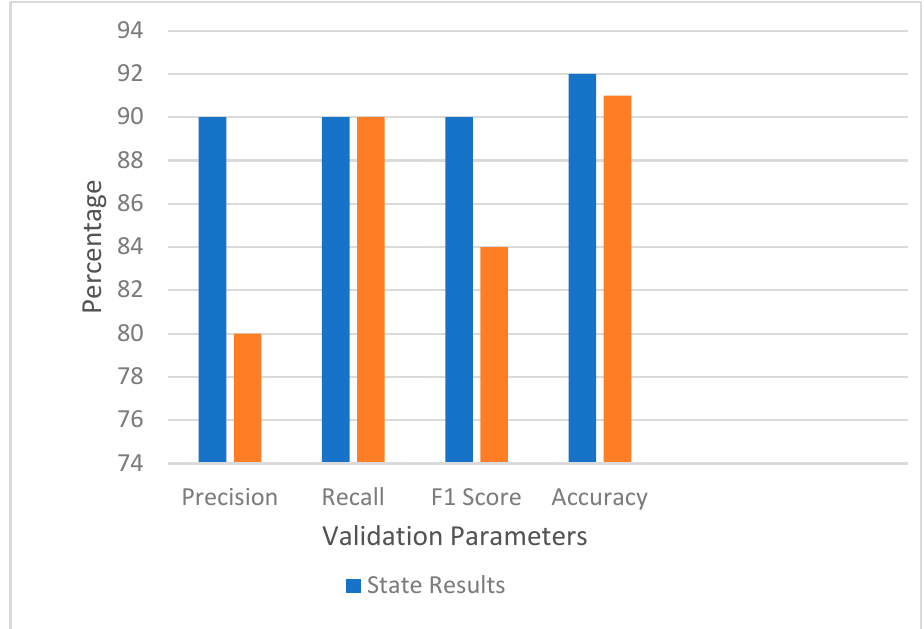
Figure 14. Model [15] (TF-IDF, MLP, 1 + 2 Grams) Stated vs. Achieved Results.